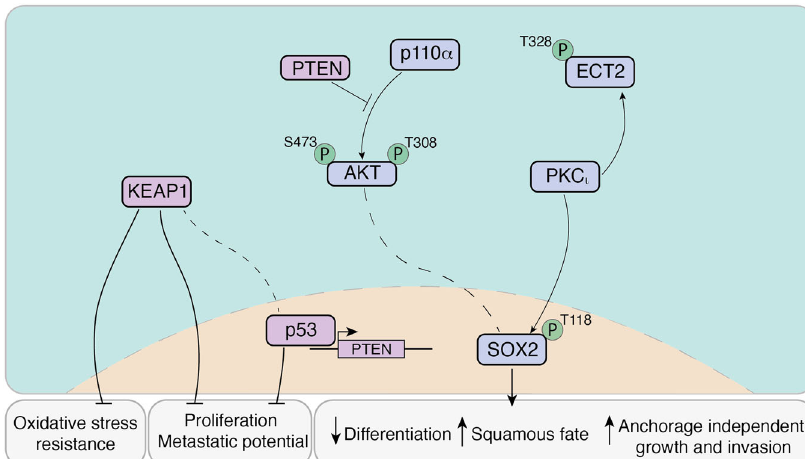
Fig. 2 Interaction of signalling pathways demonstrated in in vivo and in vitro models of LUSC. SOX2, ECT2, PKC ι (encoded by PRKCI ), and PI3K signalling cooperate to promote a neoplastic cell fate in LUSC models. AKT is a downstream effector of stimulated p110 α . Full AKT activation is achieved when phosphorylated at both positions S473 and T308 127 . High levels of SOX2 have been correlated with upregulated phospho-AKT 21 . PKC ι phosphorylates and directly interacts with ECT2 to promote anchorage-independent growth and invasion through downstream targets. PKC ι phosphorylates SOX2 favouring squamous cell fate and decreased differentiation 16 . Loss of p53, PTEN, and KEAP1 have been used to model LUSC phenotypes both in vitro and in vivo. Simultaneous loss of p53 and KEAP1 has shown synergistic effects, inducing increased proliferation, metastatic potential, and resistance to oxidative stress 31 . p53 activity can inhibit PI3K signalling through PTEN-dependent and potentially-independent mechanisms in squamous cell carcinomas 128 . Additional interactions between depicted proteins have been described in other cellular